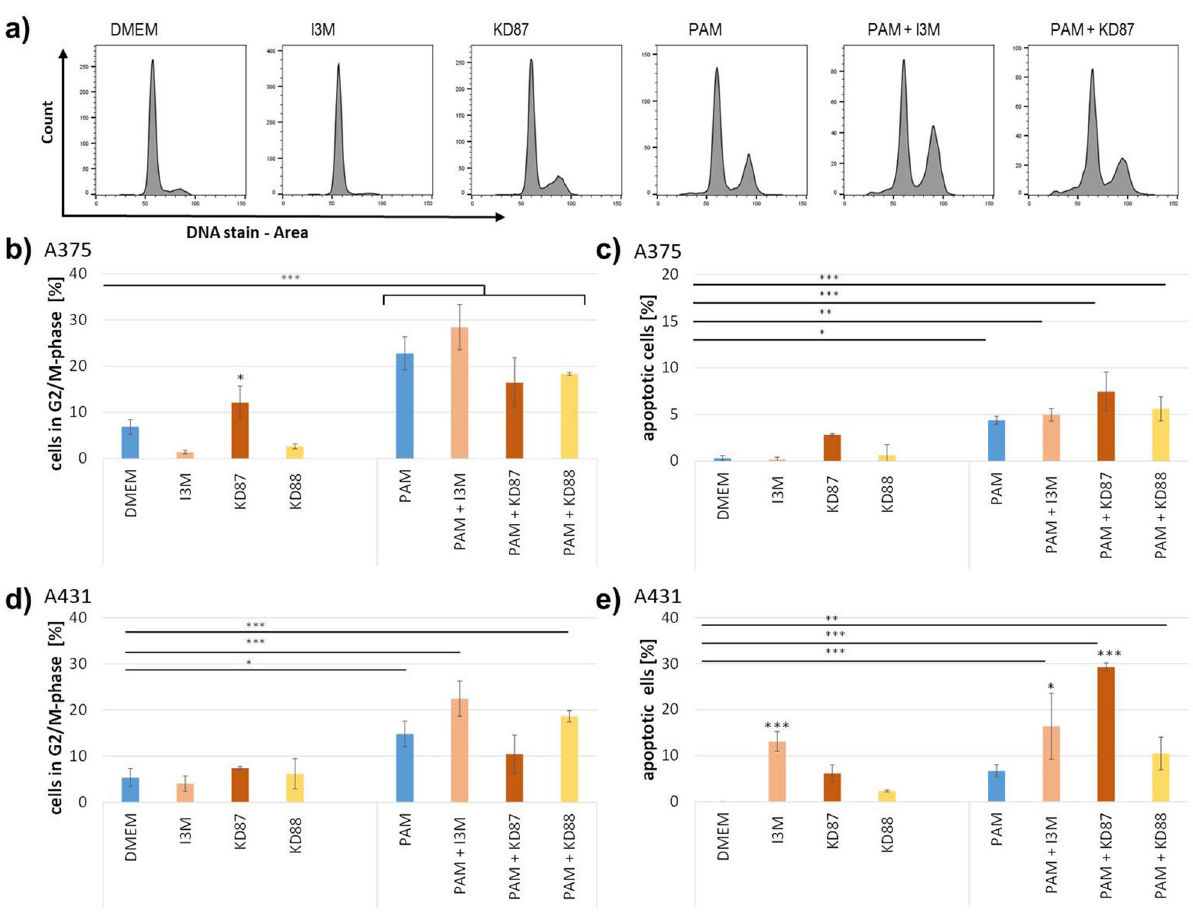
Figure 5. Cell cycle analyses of A375 ( a – c ) and A431 ( d , e ) cells. ( a ) Exemplary cell cycle histograms of A375 cells. ( b ) Percentage of A375 cells in the G2/M phase. Higher numbers after treatment with PAM indicate an arrest in G2/M, independent of the subsequent small molecule treatment. KD87 alone also caused an increase in cells in G2/M. ( c ) Percentage of apoptotic (subG1) A375 cells rose significantly after PAM. ( d ) The number of cells in the G2/M phase was increased in all PAM-treated A431 cells independent of small molecules. ( e ) Apoptosis was induced in A431 cells by treatment with I3M alone, or by the combination of PAM + either of the small molecules. Concentration of all indirubin derivatives was 10 µM. (ANOVA posthoc Tukey (*) compared with the respective control; n = 3; mean ±